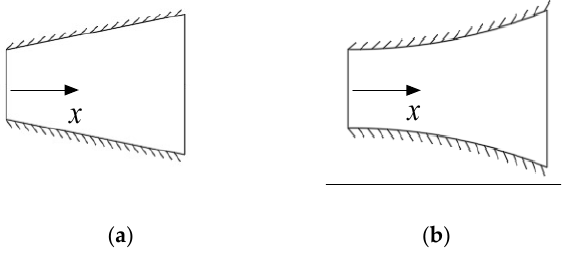
Figure 10. Form of one-dimensional variable cross-section tube. ( a ) Conical; ( b ) arc.